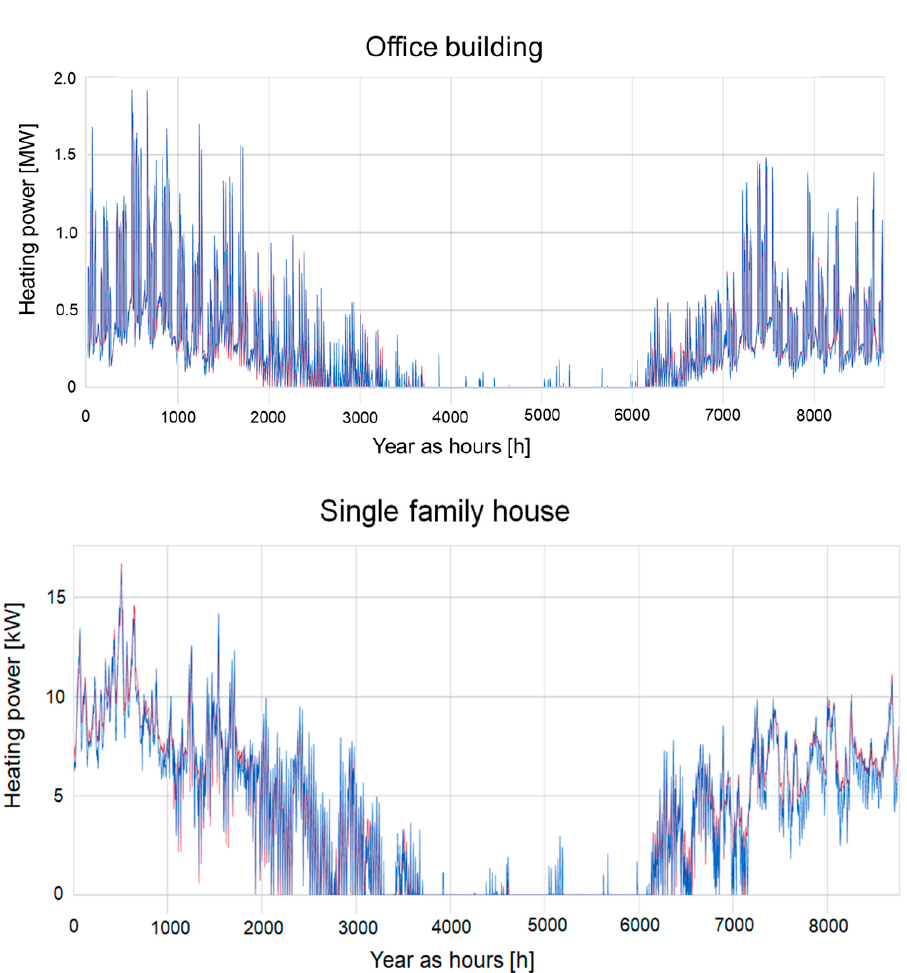
Figure 2. One year examples of measured (red) and forecast (blue) heating load for different building types (apartment, office, single family home).